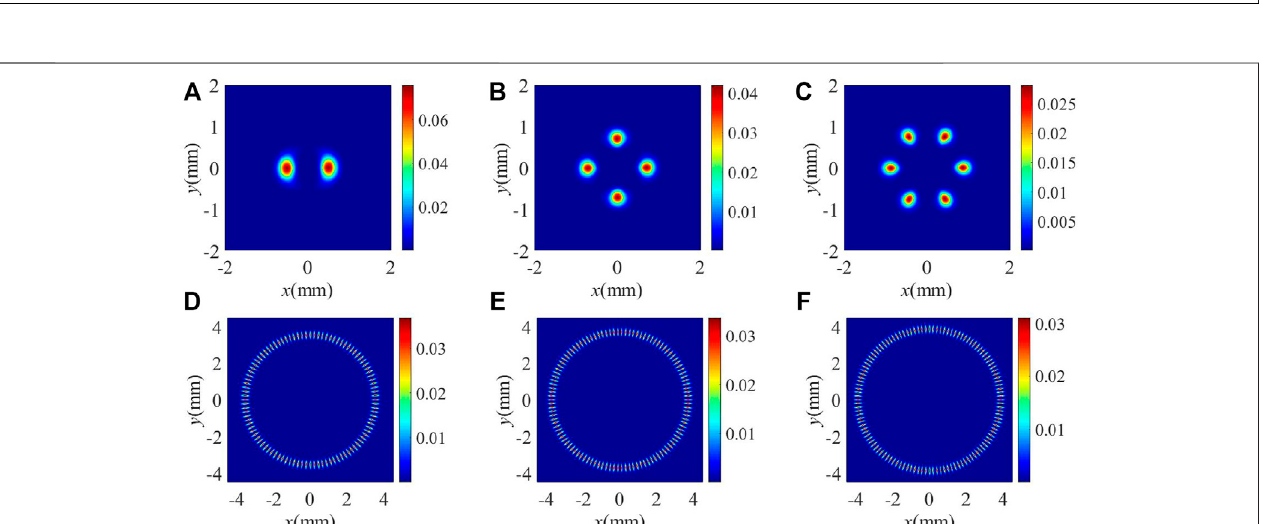
Frontiers in Physics |